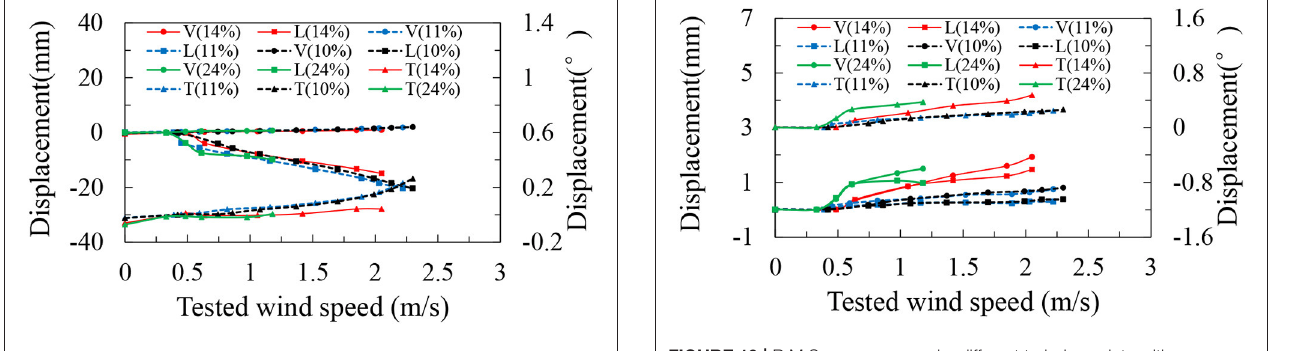
FIGURE 18 | Mean responses at mid-span.